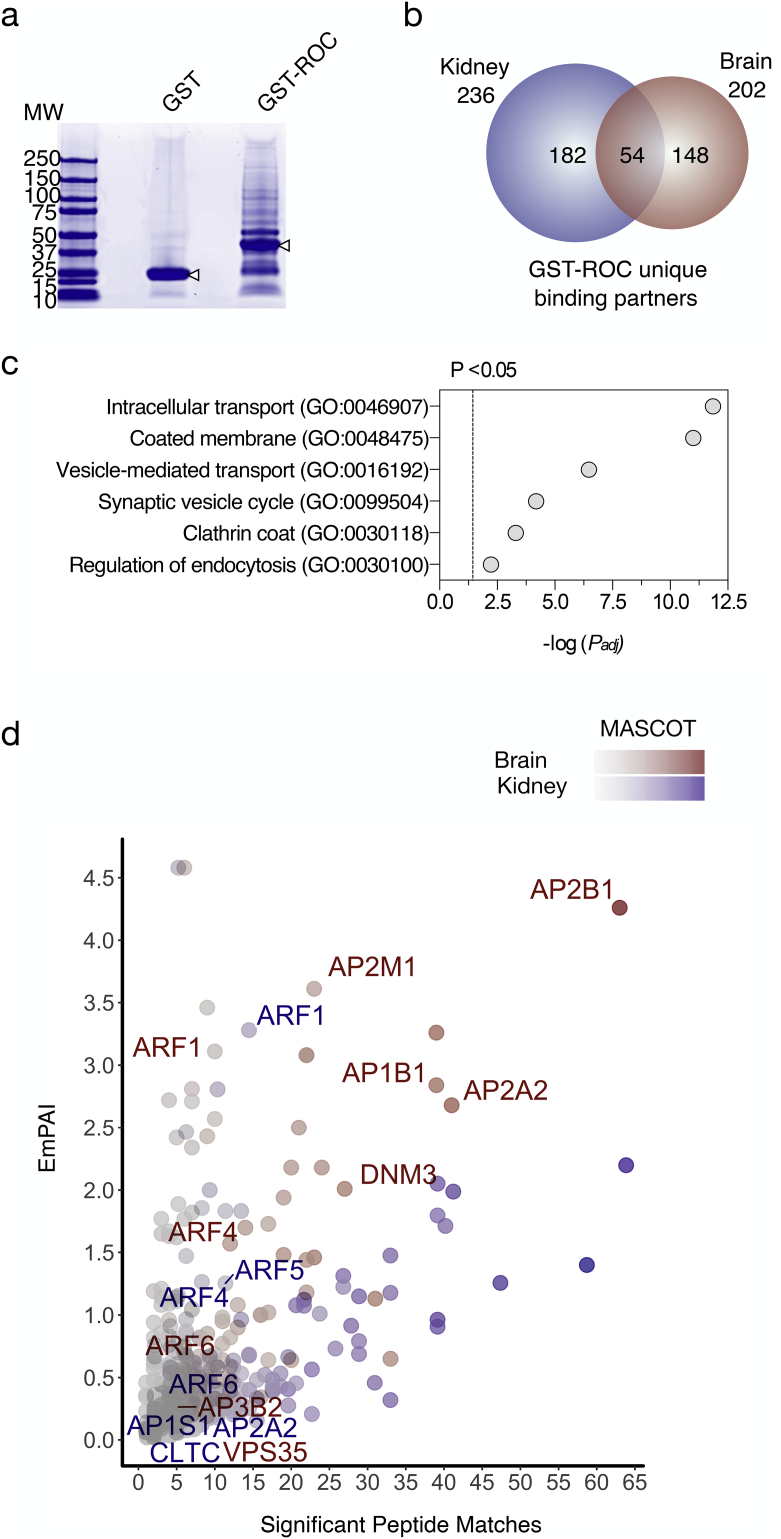
ROC domain protein-protein interaction screen (a) Brain samples incubated with GST and GST-ROC resolved using SDS-PAGE and Coomassie stain to visualise protein bands. (b) Venn diagram summary of interacting proteins, colored by tissue used for analysis (blue – kidney, red – brain) and sized by number of proteins in each set. (c) Selected GO term enrichments from BP and CC categories using gProfileR. Results show -log P values below a threshold of p < .05 after Bonferroni correction for multiple testing. (d) Scatter of mass-spectrometry results plotted by exponentially modified protein abundance index (EmPAI) and significant peptide matches. Blue points indicate kidney proteins, red represent brain and darker colors signify higher MASCOT scores. Annotated genes were found within GO nominated enrichments. (For interpretation of the references to colour in this figure legend, the reader is referred to the web version of this article.)